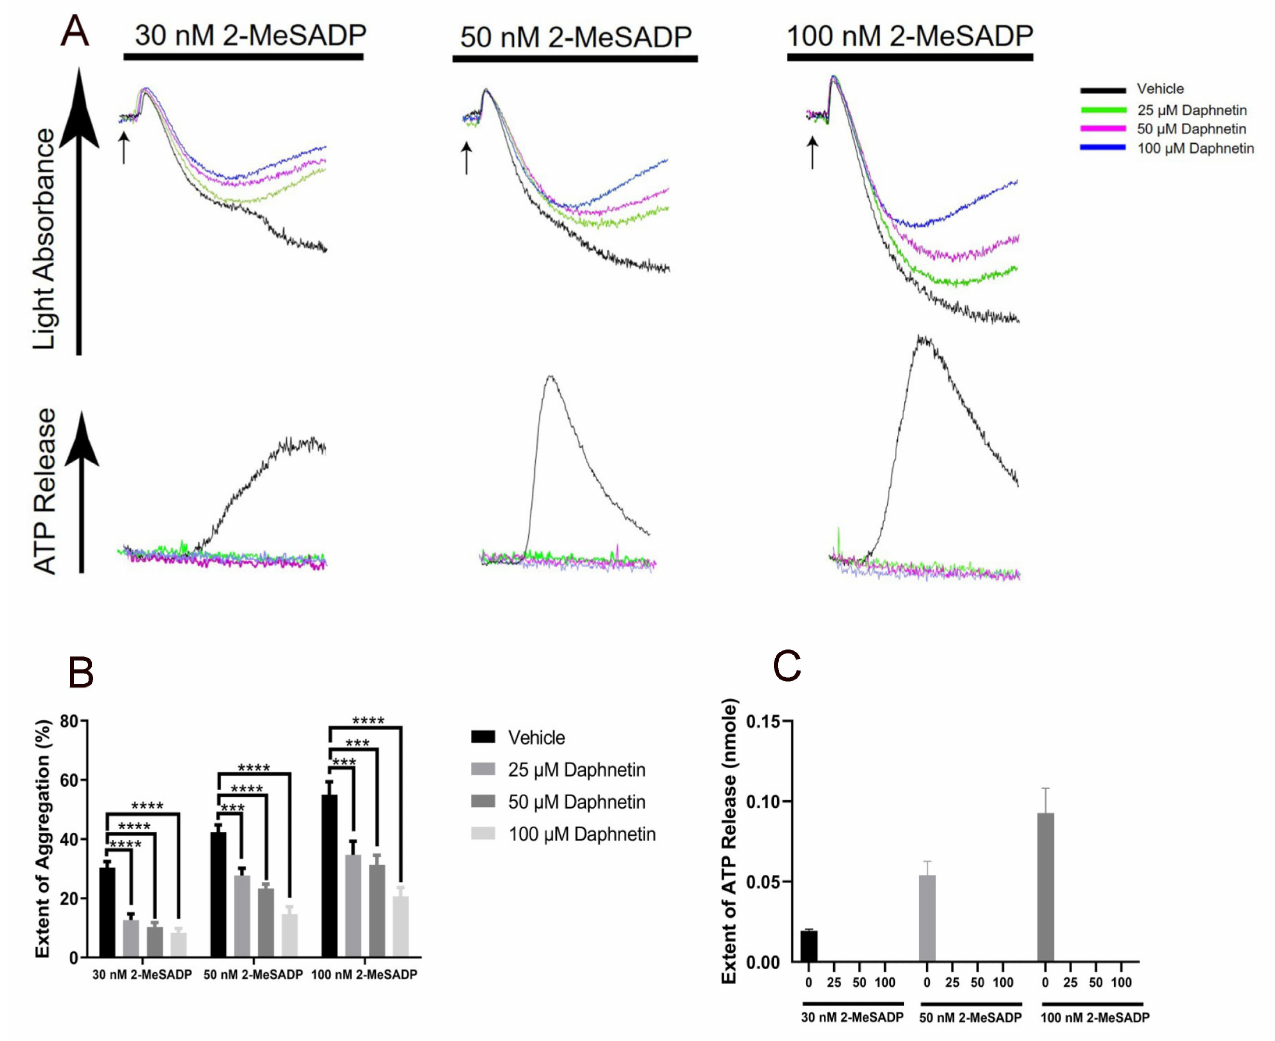
Figure 2. The effect of daphnetin on 2-MeSADP-induced aggregation and secretion in non-aspirinated platelets. ( A ) Washed murine platelets were stimulated with 30 nM, 50 nM, and 100 nM 2-MeSADP in the presence of different concentrations of daphnetin. All data are representative of three independent experiments ( n = 3). Quantification of the ( B ) extent of aggregation and ( C ) dense granule secretion from panel A. Data are shown as mean ± SE ***, p < 0.001; ****, p <